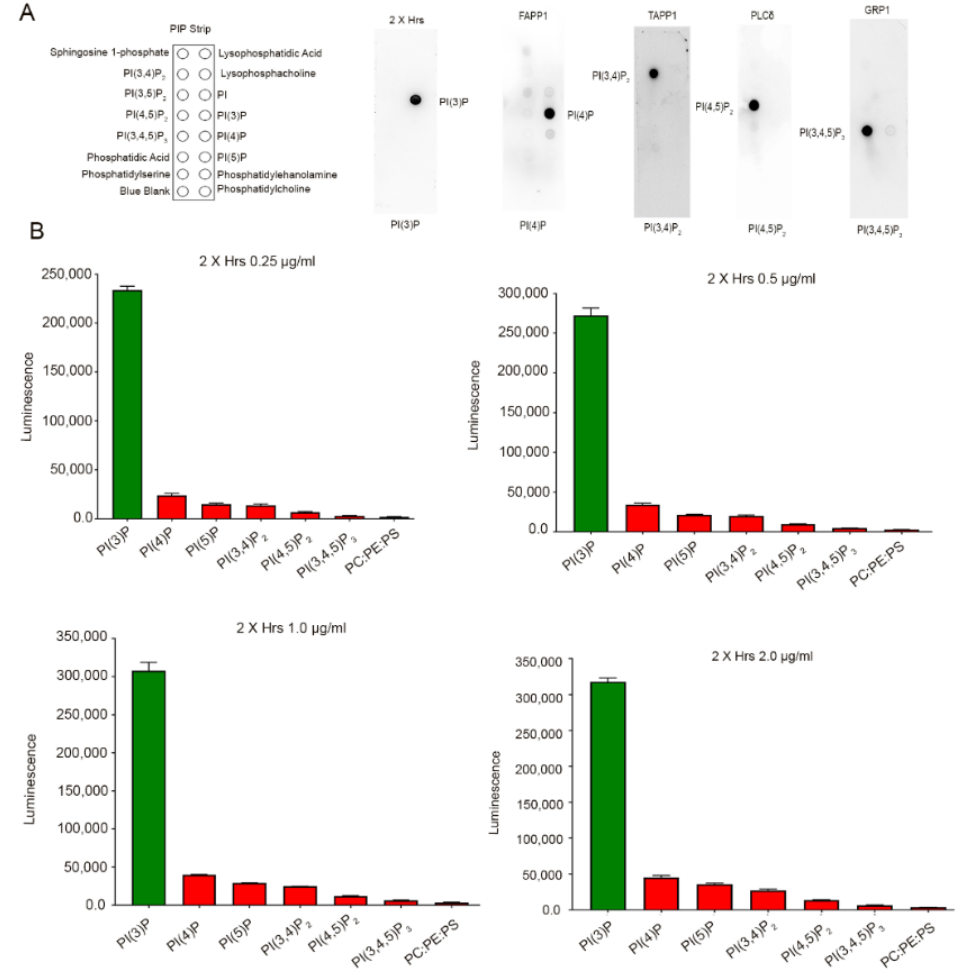
Figure 2. Protein-lipid overlay assay. In vitro protein-lipid overlay assay was carried out by incubating PIP-strips that were immobilized with 100 pmol of 15 lipids ( A ) with a purified PI-binding protein, 2 × Hrs-1D4, FAPP1-1D4, TAPP1-1D4, PLC δ -1D4, and Grp1-1D4, followed by immunoblot analysis with the anti-rhodopsin antibody ( A ). The PI ELISA assay was carried out with di ff erent concentrations of 2 × Hrs (0.25, 0.5, 1.0, and 2.0 µ g / mL) using 2.5 pmols of PI(3)P, PI(4)P, PI(5)P, PI(3,4)P 2 , PI(4,5)P 2 , PI(3,4,5)P 3 , and PC / PE / PS (15:35:15) ( B ). The PI assay was carried as described in the methods. Data are mean ± SEM ( n = 3).